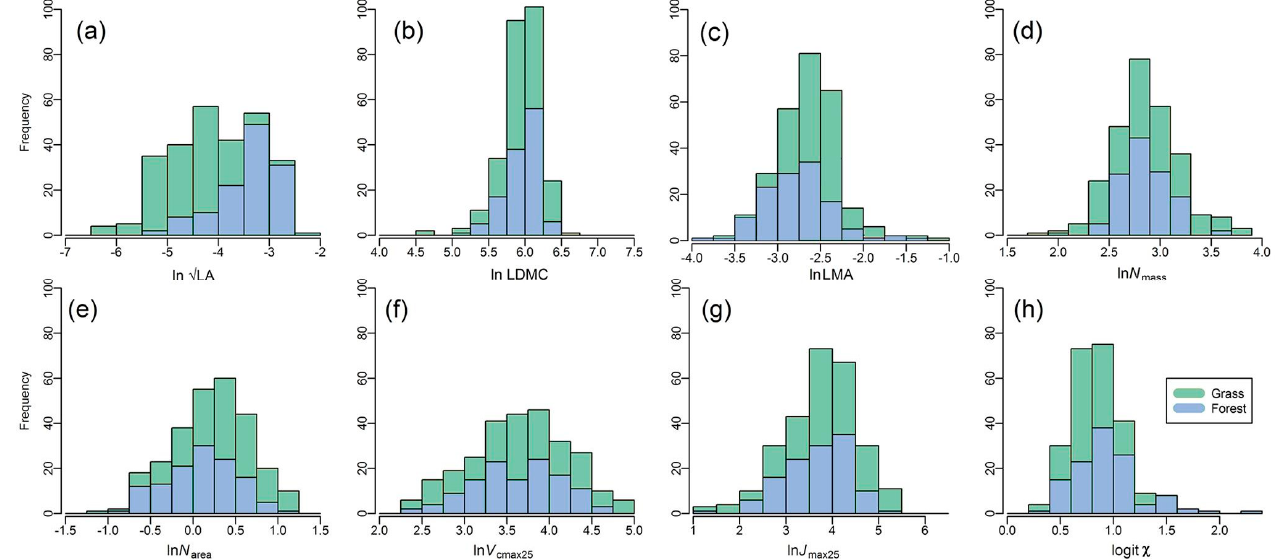
Figure A1. Distribution histogram of the eight studied plant functional traits, including ( a ) LA: leaf area, ( b ) LDMC: leaf dry mass content, ( c ) LMA: leaf mass per area, ( d ) N mass : leaf nitrogen content, ( e ) N area : leaf nitrogen per area, ( f ) V cmax25 : ( h ) χ : ratio of intercellular to ambient CO 2 concentration. Table A1. Trait loading, eigenvalues and percentage of trait variation explained by redundancy analysis (RDA) axes constrained by climate and soil variables. Values greater than 0.4 are labeled in bold.